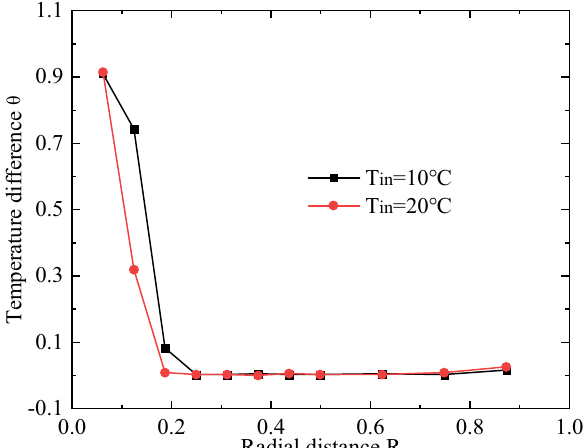
Fig. 15 Temperature change of L4 at different inlet temperatures when Re is 1975 and Fo is 0.9 in forward